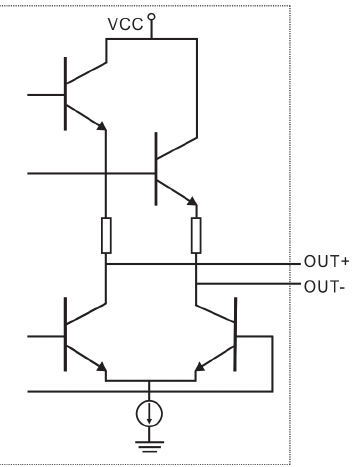
Figure 3. Physical layer structure of sender.